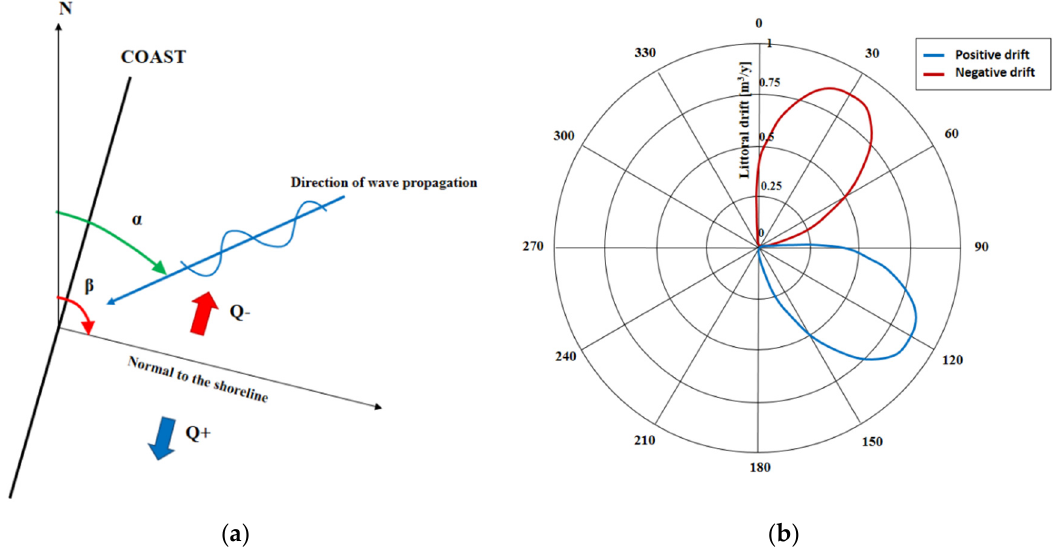
Figure 4. ( a ) Definition sketch for a stretch of coast characterized by a shoreline orientation β and affected by a wave propagating from α ; ( b ) example of net littoral drift rose. The blue line denotes positive littoral drift, while the red line denotes negative littoral drift.